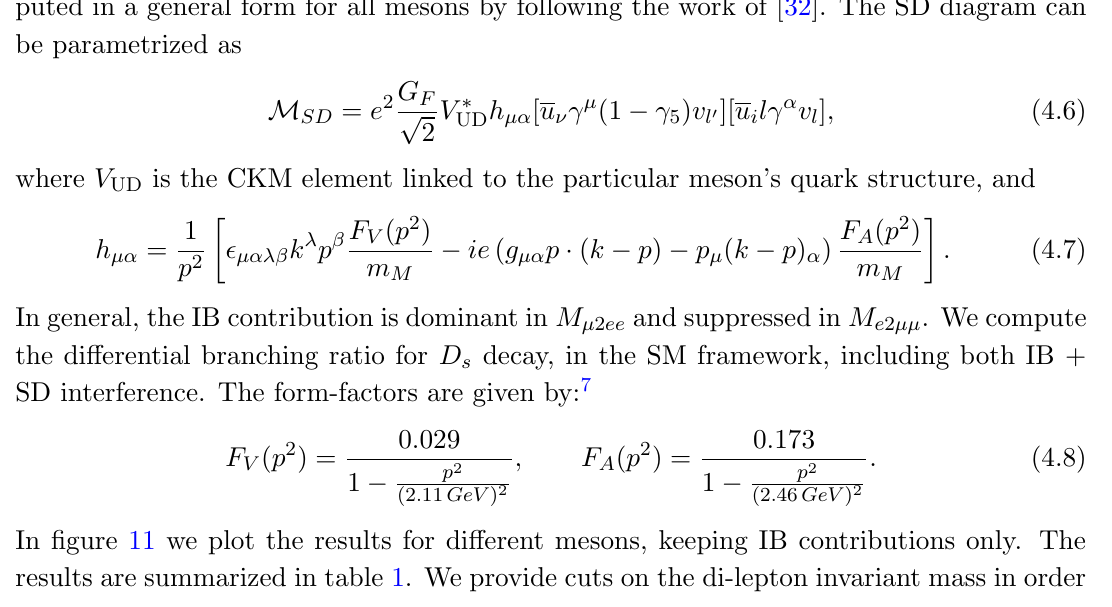
p , the region around s (cid:24) m Z X 10